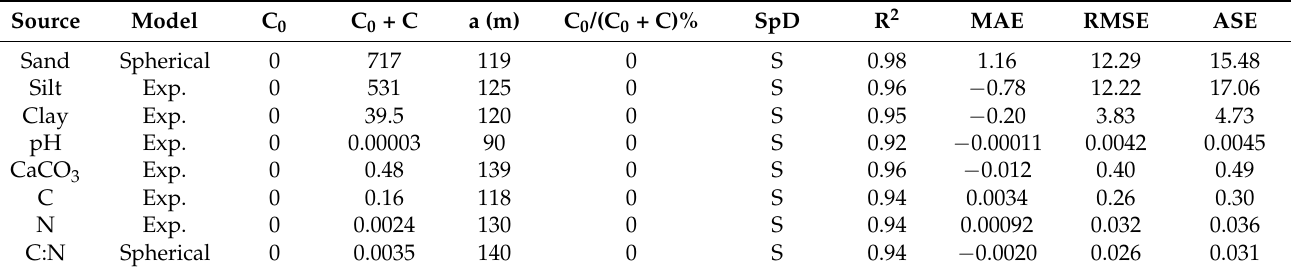
Table 7. Semi-variogram parameters of soil traits.